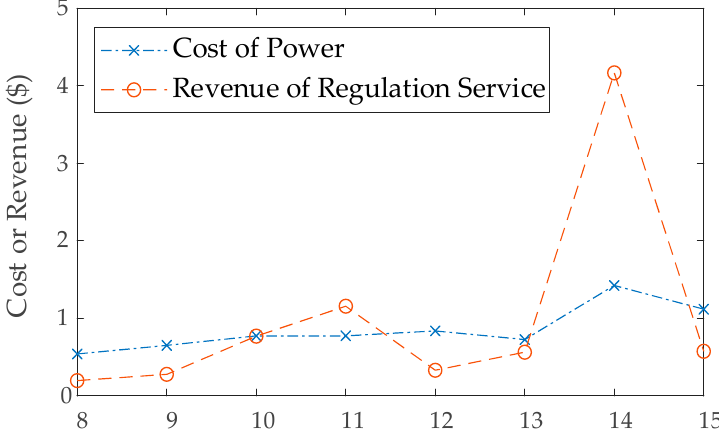
Figure 6. The cost of electricity and the revenue in regulation market.